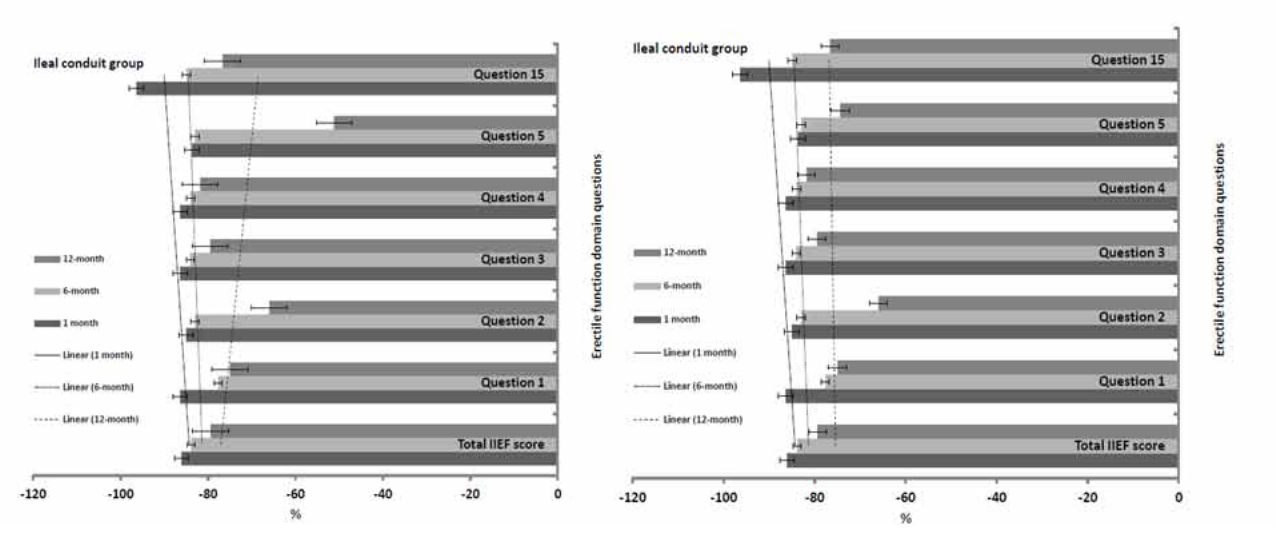
Figure 1 - Percent changes from baseline in erectile function domain total score and questions during follow-up period. Bars represent error bars with standard error.